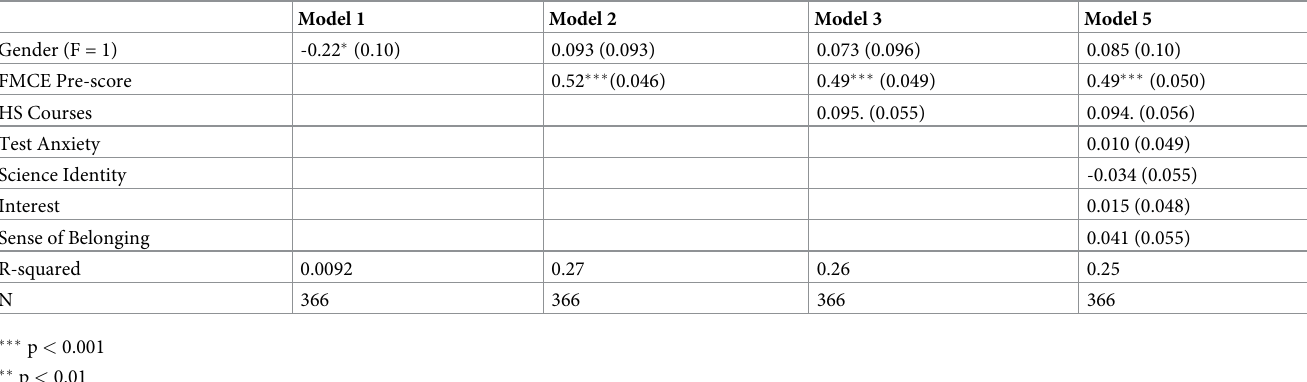
Table 5. Multivariable linear regression predicting the effects of gender, social psychological variables, and FMCE pre-scores on exam grades.